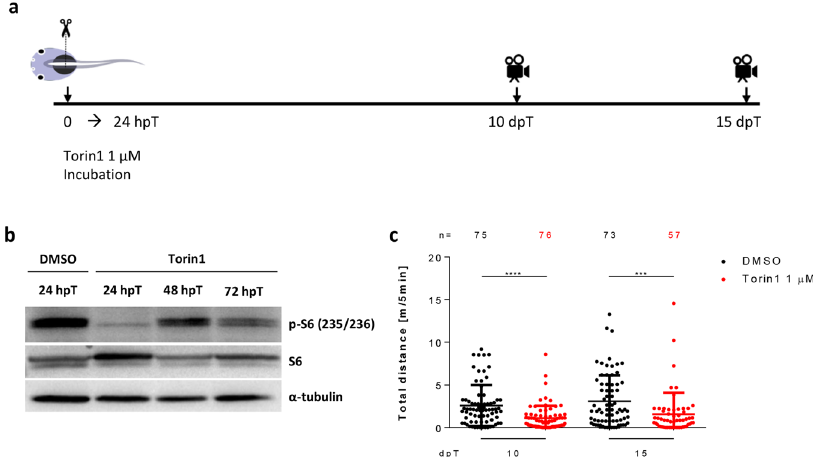
Fig. 5 Early inhibition of mTOR signaling impairs swimming recovery. a Scheme illustrating the experimental timeline. The mTOR pathway was inhibited incubating animals with Torin1 1 µM during the fi rst 24 hpT, and swimming distance was recorded at 10 and 15 dpT. b Western blot for S6 and p-S6 in total protein extracts obtained from spinal cords isolated from X. laevis incubated immediately after transection for 24 h with DMSO (vehicle) and Torin1 (drug) and collected at 24 hpT for vehicle treatment and at 24, 48, and 72 hpT for drug treatment. c Dotplot of swimming distances of animals treated with vehicle (black dots) and 1 µM Torin1 (red dots), measured at 10 and 15 dpT. Data indicate the mean ± SEM, from three independent experiments. *** P < 0.001, **** P < 0.0001, from a Mann – Whitney U -test comparing Torin1-treated animals to control, at each time point. All the blots included in this fi gure were derived from the same experiment and were processed in